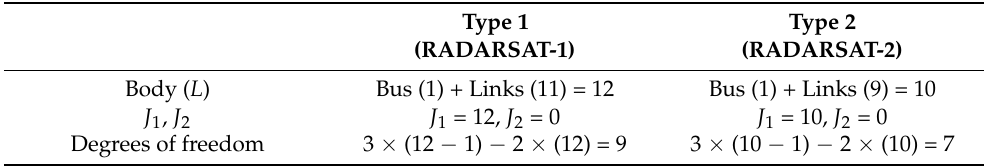
Table 1. Evaluation of total